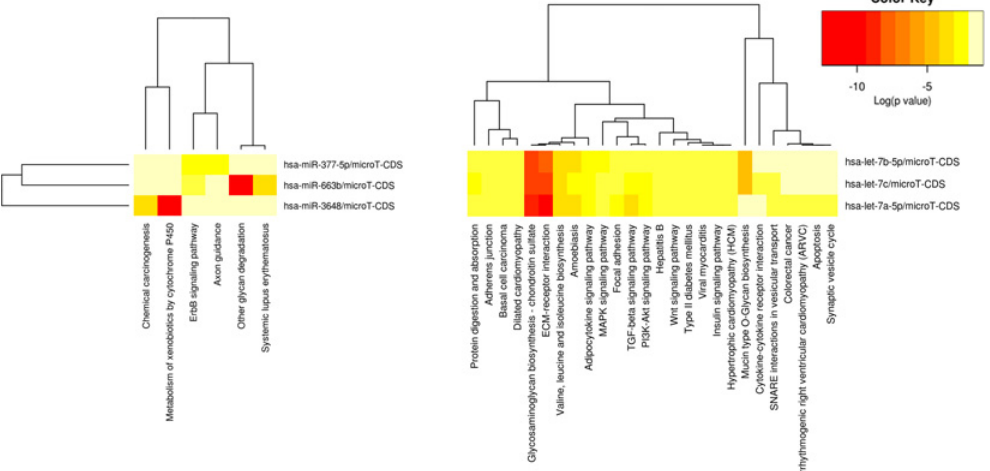
Fig 3. Pathway analysis for putative miRNA target genes. Pathways showing significant enrichment in putative target genes for miRNAs positively correlated with recurrence score (left) or negatively correlated with recurrence score (right) were